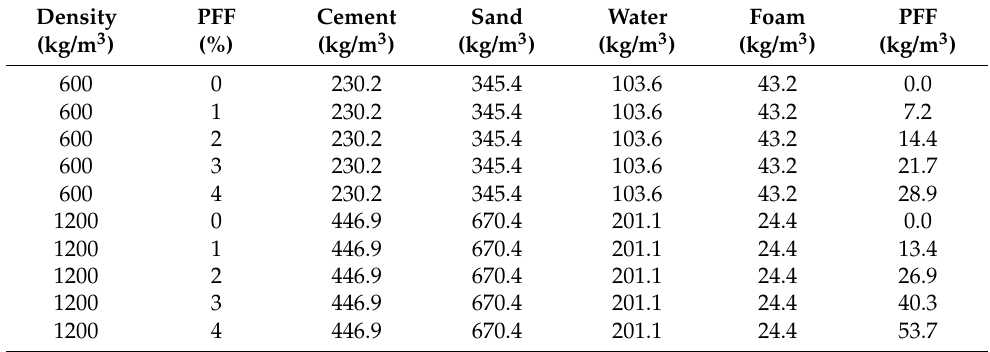
Table 2. Mixture proportions of foamed